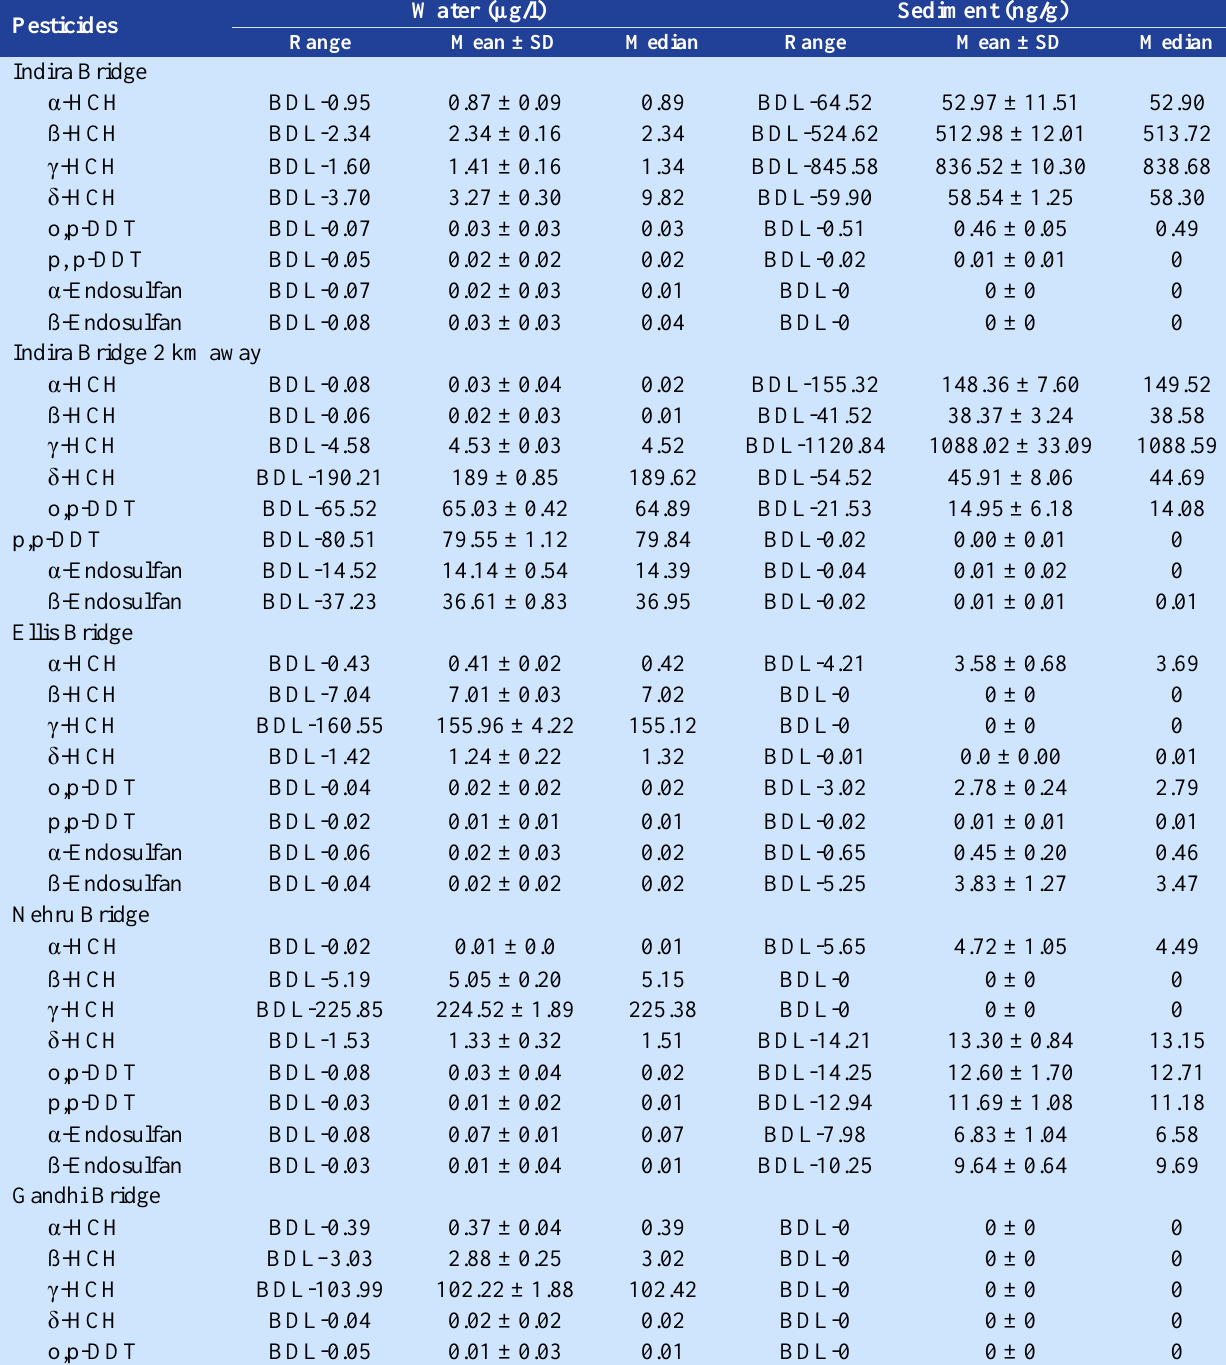
Table 2. Basic statistics of organochlorine pesticides (OCP) residues in water and sediment samples of the Sabarmati